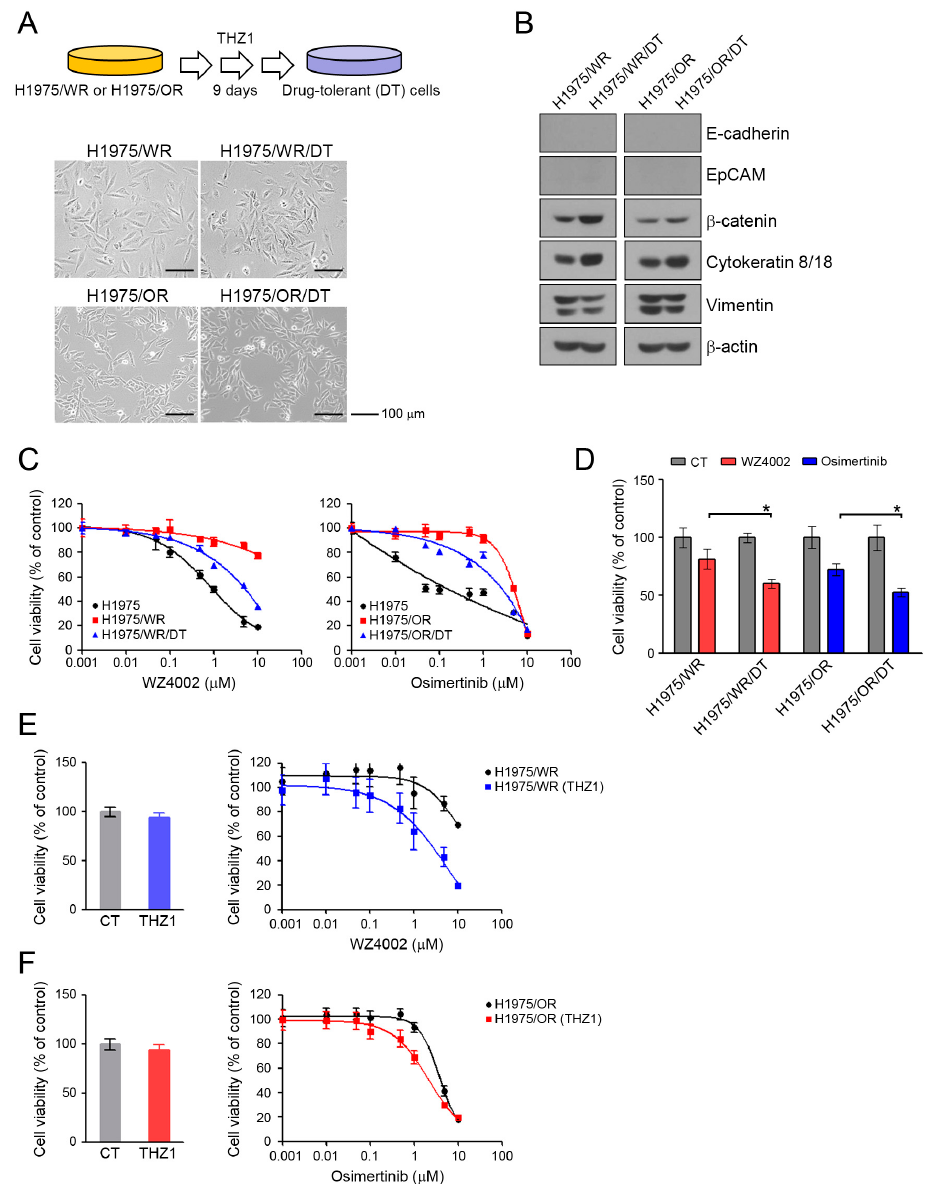
Figure 5. Morphological changes and recovery of the sensitivity to EGFR-TKIs by THZ1-tolerant cells. ( A ) DT cells were generated by repeated exposure to 100 nM THZ1 (3 times in 9 days). Morphologic changes were determined by using a light microscope. ( B ) EMT-related molecules were analyzed by western blotting. ( C ) Cells were treated with the indicated doses of WZ4002 or osimertinib for 72 h, and cell viability was determined by the MTT assay. ( D ) Cells were treated with 1 μ M WZ4002 or osimertinib for 48 h. Cell viability was determined by cell counting. ( E,F ) Cells were treated with the indicated doses of a single drug (WZ4002 or osimertinib) or in combination with 10 nM THZ1 for 72 h. Cell viability was determined by the MTT assay. * P < 0.05.